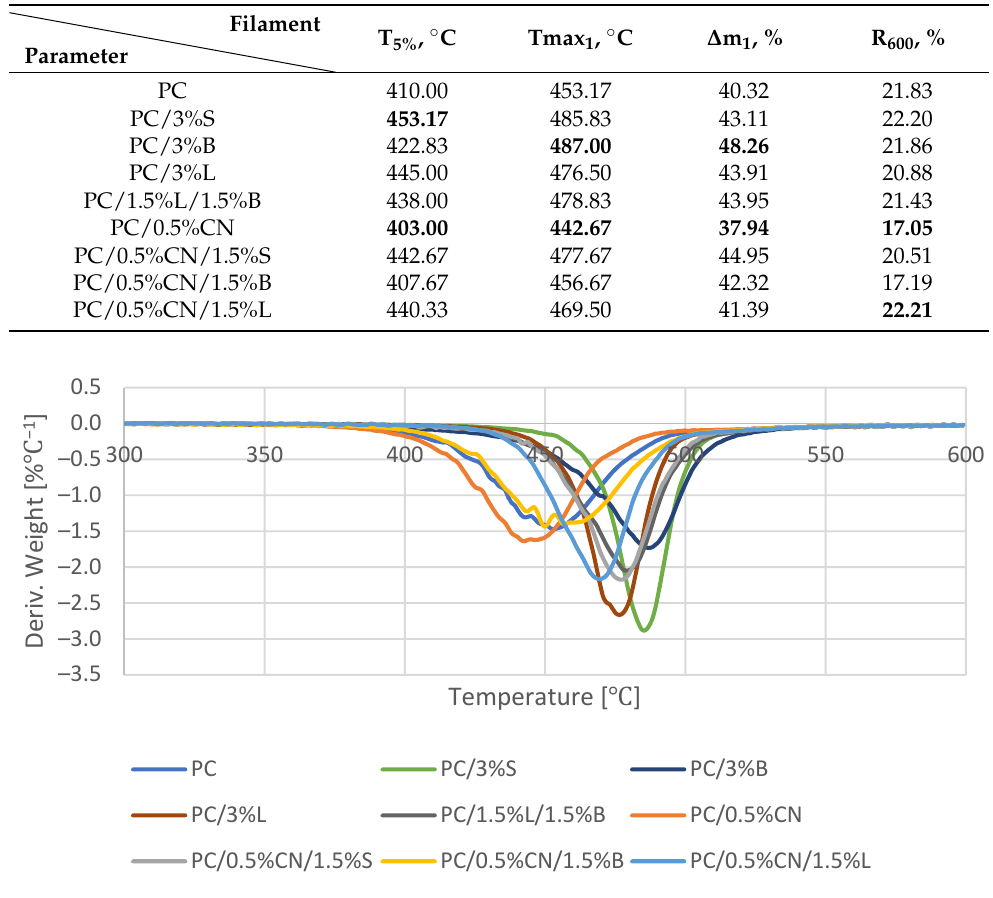
Figure 10. Thermograms of DTG. Table 5. The results of research on the properties of thermostability of composites.